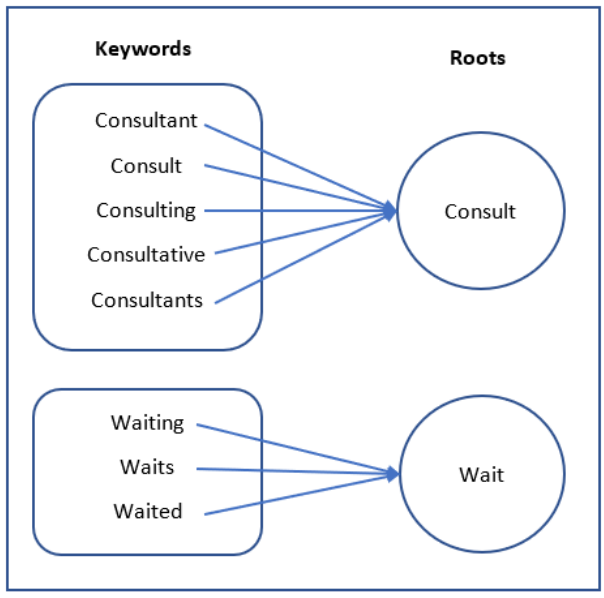
Figure 3. Stemming